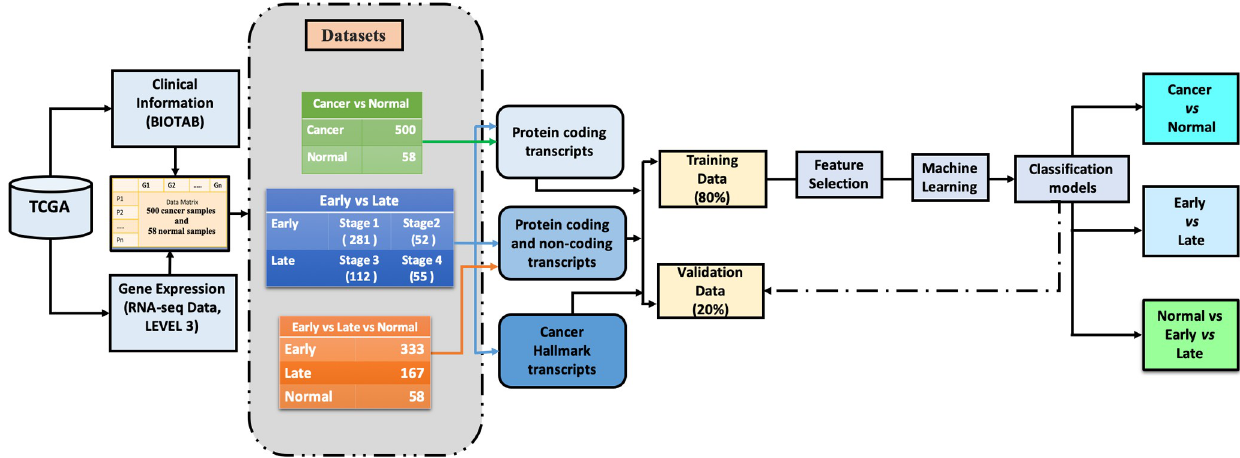
Fig 1. The overall flow of the study, including the number of samples in each class and types of feature selections explored for the development of machine learning models. The green arrows represent that only protein-coding features have been explored to segregate cancer and normal samples. The blue arrows indicate that both protein-coding and non-protein coding features individually and in combination have been explored to segregate early vs late-stage samples. For multiclass classification, protein-coding and non-protein coding transcripts in combination are explored to segregate early, late and normal